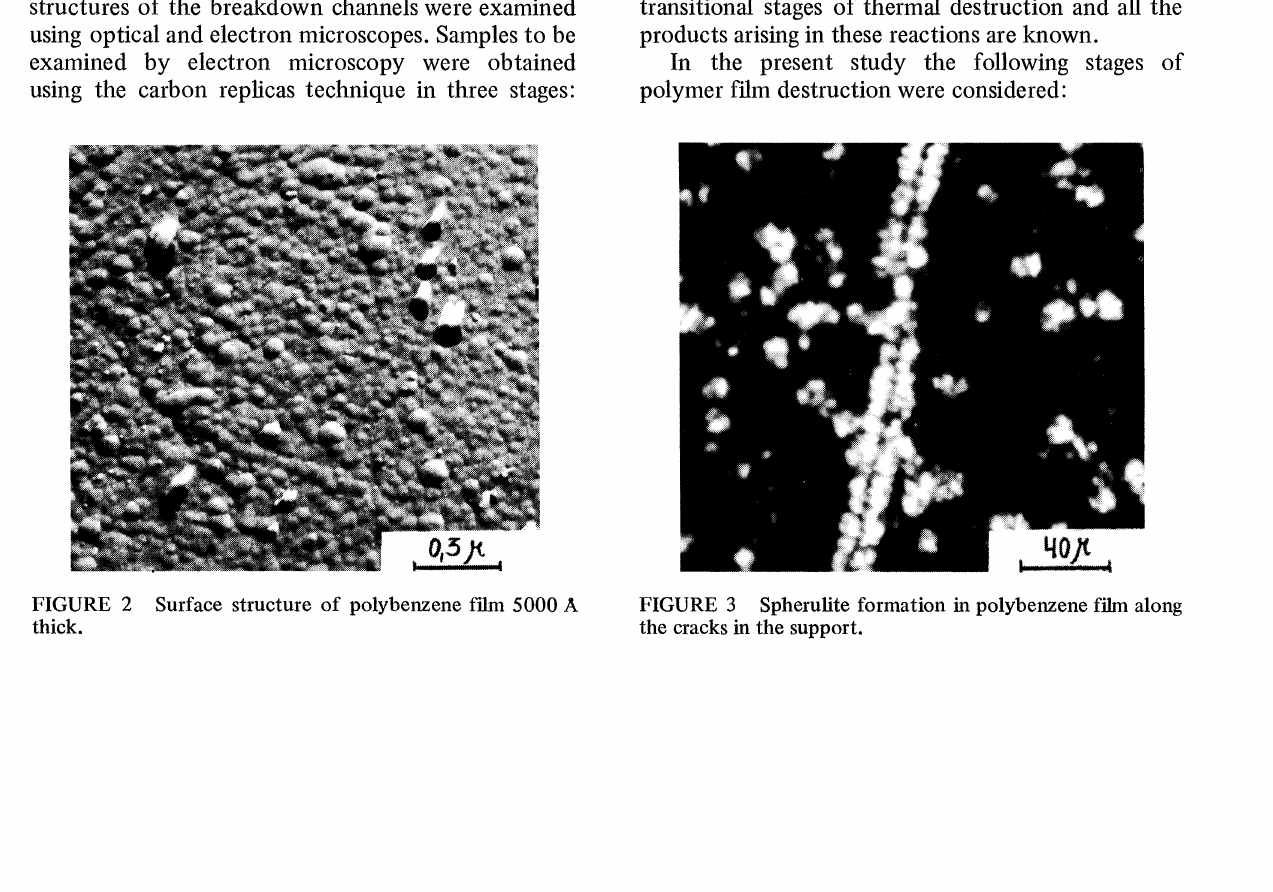
FIGURE 2 Surface structure of polybenzene film 5000 A thick.